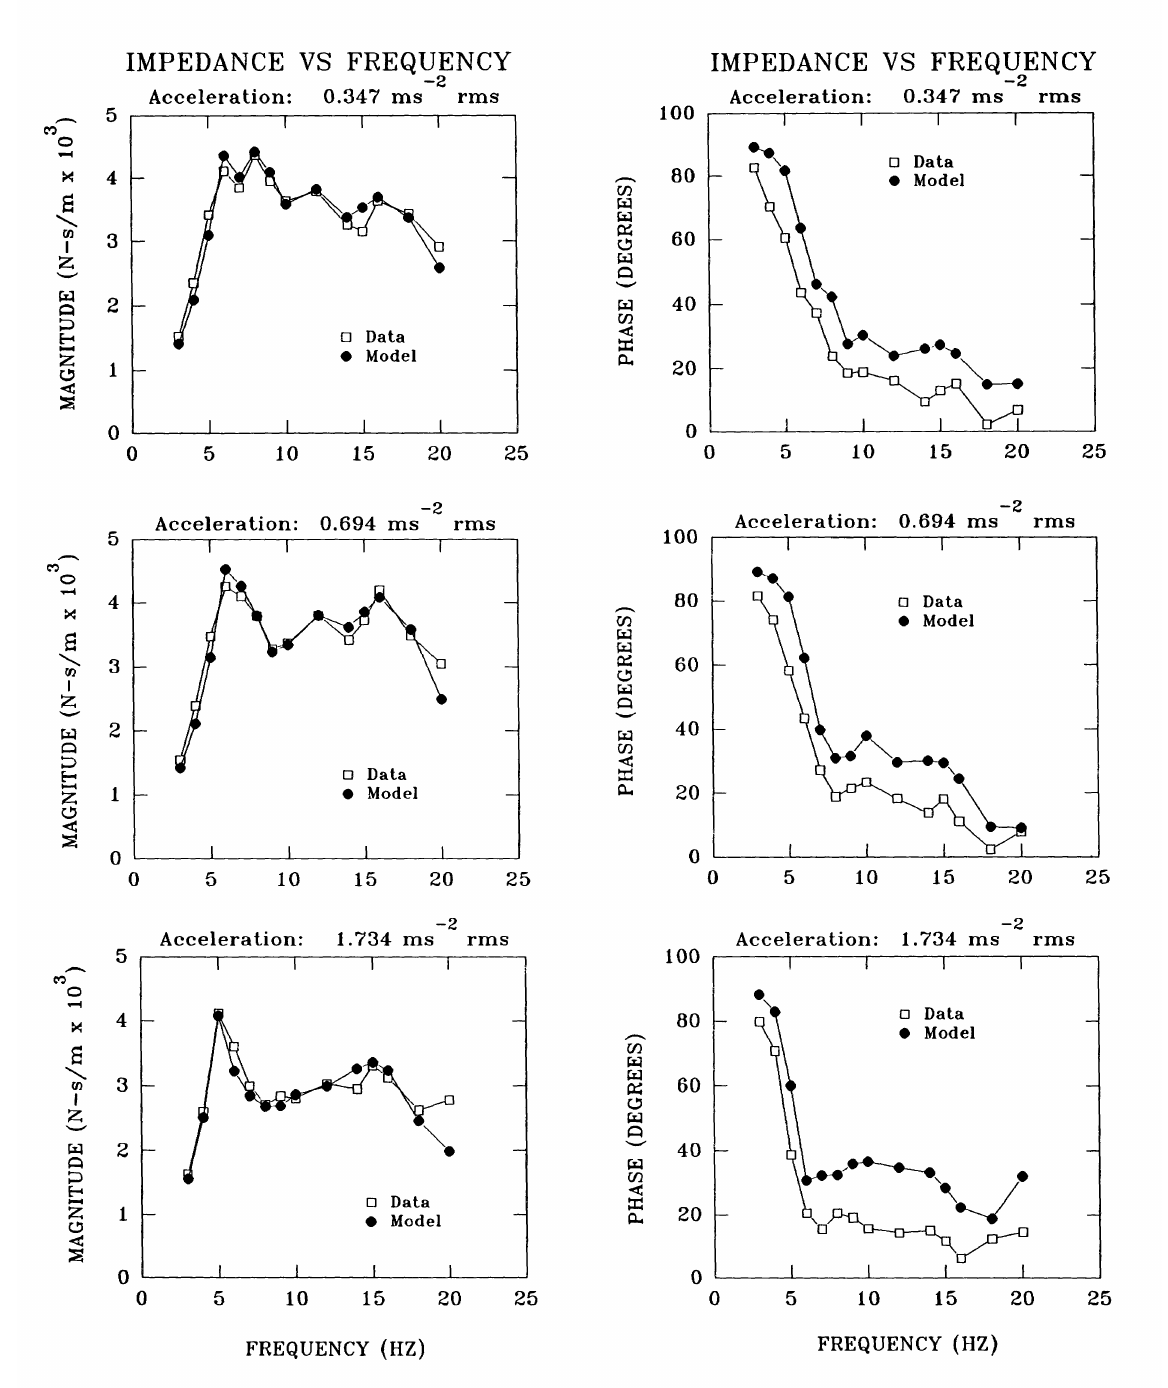
FIGURE 5 Modeling results for the three acceleration